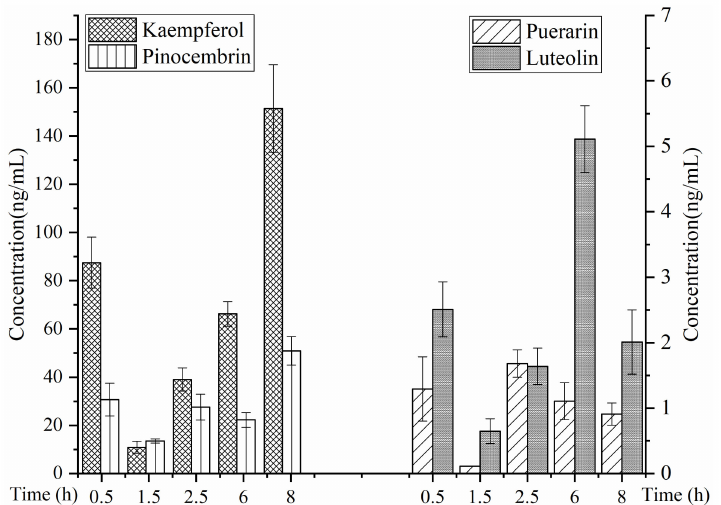
Figure 16. Prostate tissue distribution of four analytes after oral administration of the aerial parts of G. uralensis ( n =